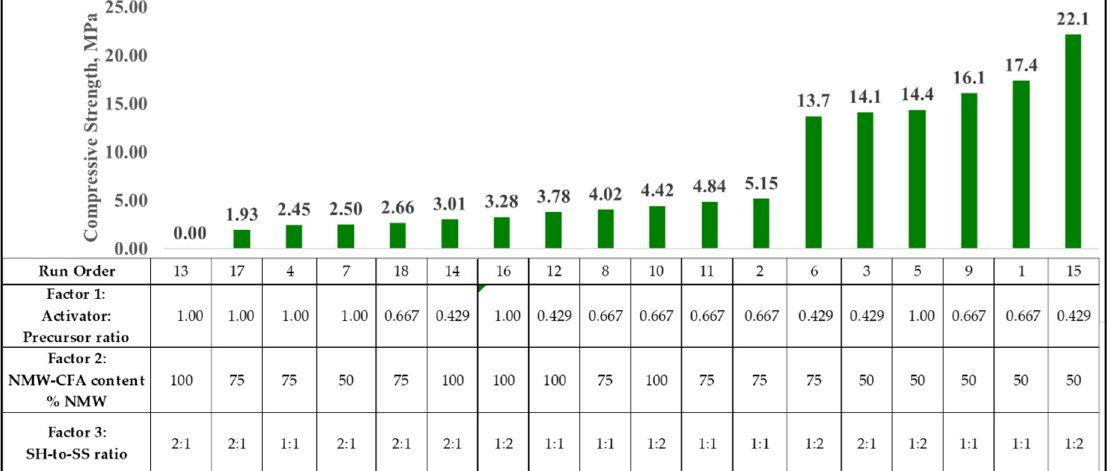
Table 6. Summary of model statistics for UCS.